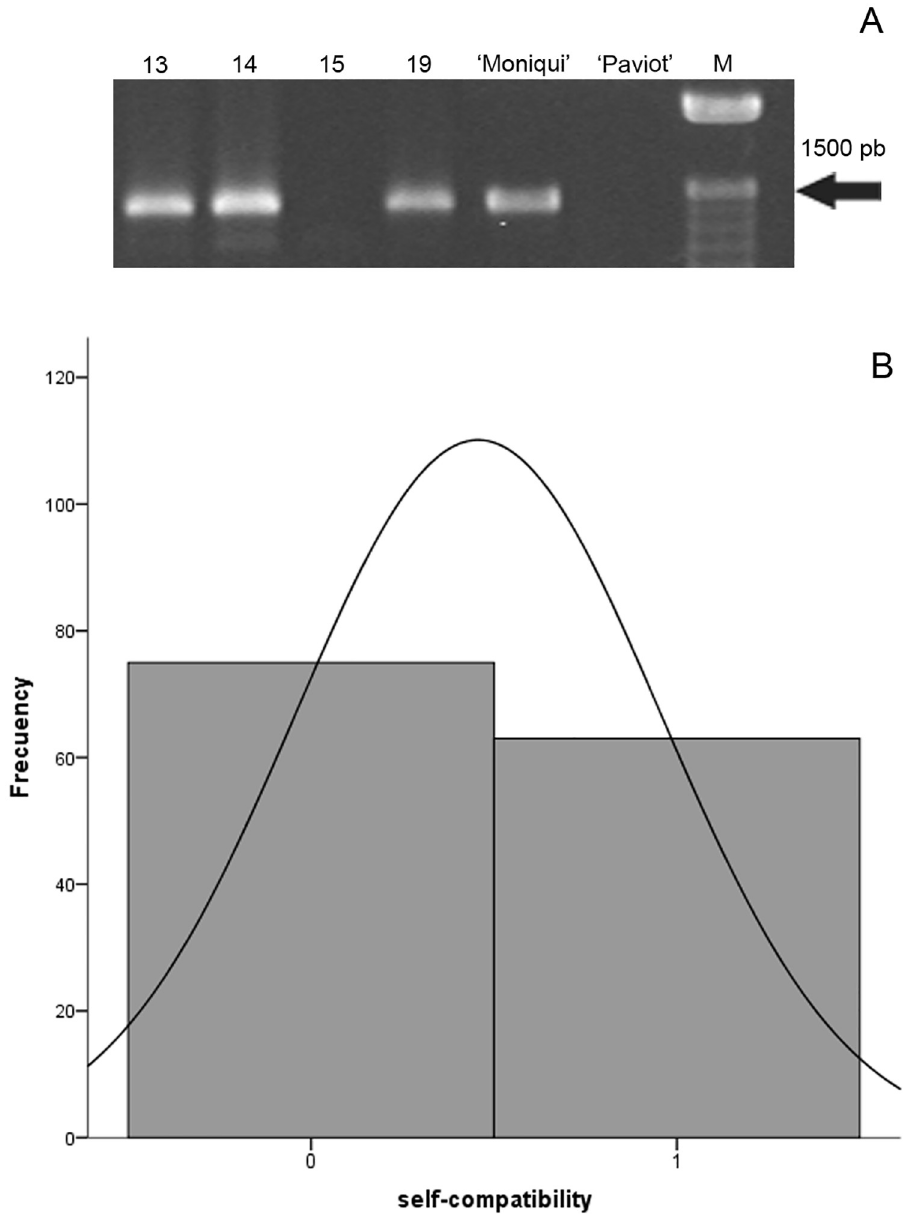
Fig 5. PCR analysis of the self-incompatibility allele in the 156 individuals from the ‘Moniqui’ x ‘Paviot’ apricot population. Amplified fragments were obtained by PCR from genomic DNA using AS1 and Pru-C4R [35] primers. Results from 4 individuals of the ‘Moniqui’ x ‘Paviot’ progeny (13, 14, 15 and 19) and their parents ‘Moniqui’ and ‘Paviot’. Band size was determined by comparison with 100-bp molecular weight marker (M) on the right.